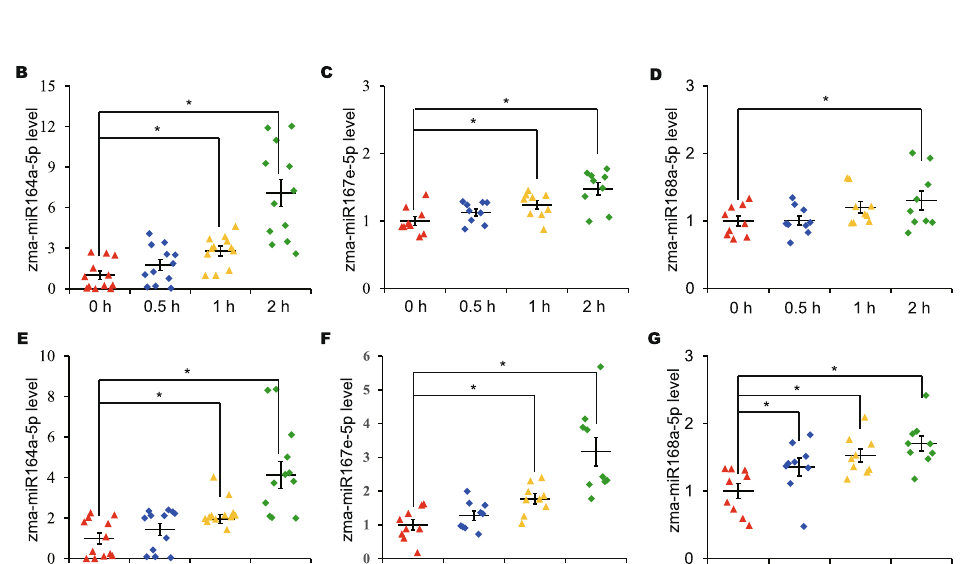
detectably increased concentrations of miRNAs derived from fresh maize juice and synthetic miRNAs with 2 ′ -O-methyl modification in the internal liquid of the intestine (Fig. 3B–G), which suggested that the exogenous plant miRNAs in food could cross the intestinal barrier, although an in vivo test was required to further explore the mechanism by which these exogenous miRNAs subsequently enter the blood and solid tissues. Dietetically absorbed maize miRNAs may be packaged into exosomes and present in the cir- culation. Our findings proved that the exogenous plant miRNAs in food could cross the intestinal barrier in vitro . Therefore, we sought to investigate the absorption of plant miRNAs in vivo and assessed the levels of maize-derived miRNAs in the serum of pigs fed fresh maize. As shown in Fig. 4A–E, the levels of all five tested maize miRNAs (zma-miR164a-5p, zma-miR166a-3p, zma-miR167e-5p, zma-miR168a-5p and zma-miR319a-3p) gradually increased after one meal of fresh maize, reaching peak values at 6 or 12 hours within the first 24 hours. Following 7 days of access to fresh maize feed ad libitum , the maize miRNAs maintained a stable detectable level in the serum ( Fig. 4A–E ) . We next assessed whether these plant miRNAs were located in exosomes in porcine serum by performing ultracentrifugation. All five tested maize miRNAs detected in the serum were primarily present in serum exosomes (~58.2% of the concentration in the serum) ( Fig. 4F ) . Direct PCR-Sanger sequencing